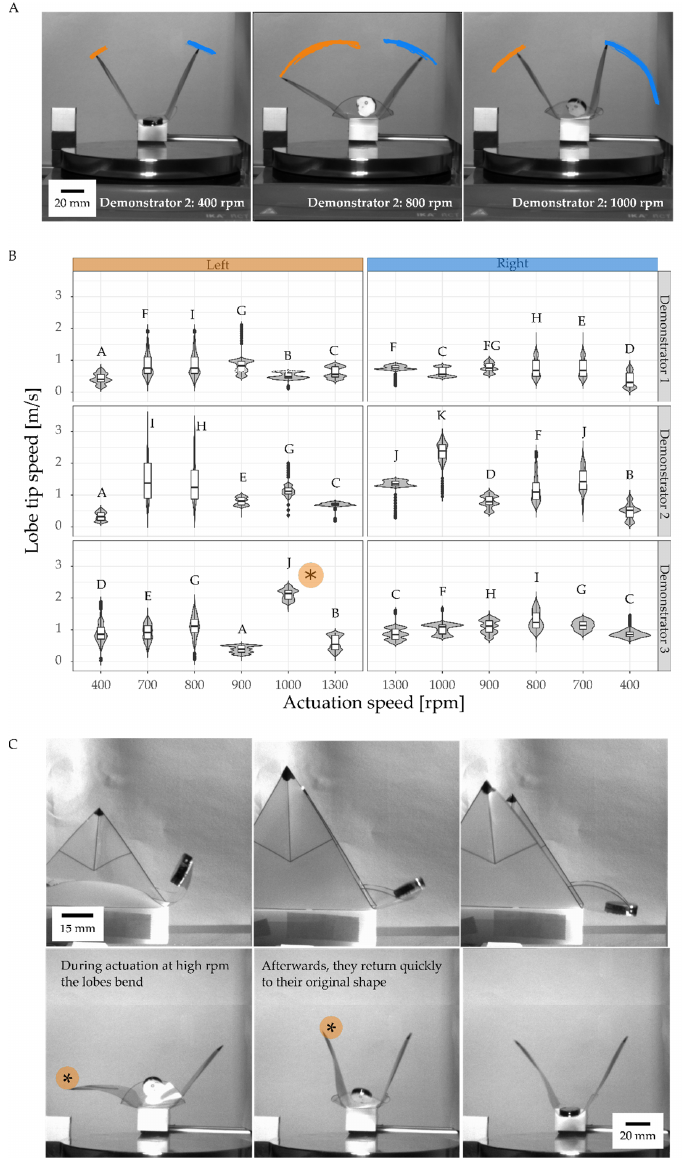
Figure 5. Motion analysis of magnetically driven oscillating VFfs with velocities approximating to natural frequency. With higher actuation velocity (higher rpm), the movement speed and amplitude increase (motion tracks indicated by orange and blue lines) ( A ). Three VFfs were tested at six different actuation speeds ( B ). Significance levels are indicated by the capital letters next to each boxplot. Different letters represent significant differences from other results with p -values below 0.05. Recording frame-rate of 1000 fps for a video duration of 3 s resulted in 3000 values for each speed ( n = 3000) of the movement of the three tested VFfs. Highest velocities were observed when a lobe bent during the outward and downward movement and then snapped back into its original curvature ( C ). The images illustrate the difference in speed of the left and the right lobe of demonstrator 3 at 1000 rpm. * indicates the fastest snapping lobe in ( B , C